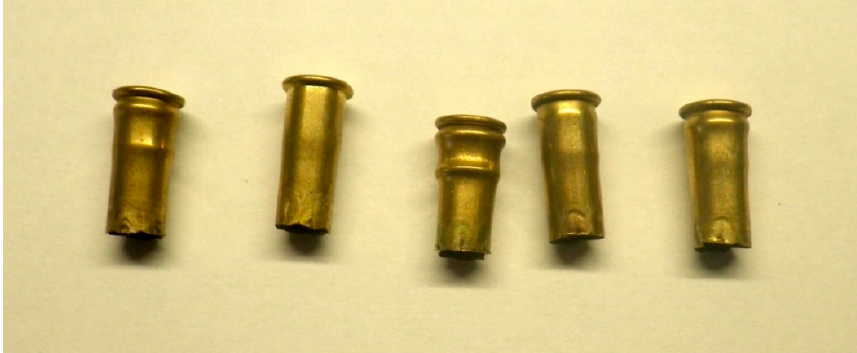
Figure 18. Range of deformities seen in cartridge cases fired using the same device.